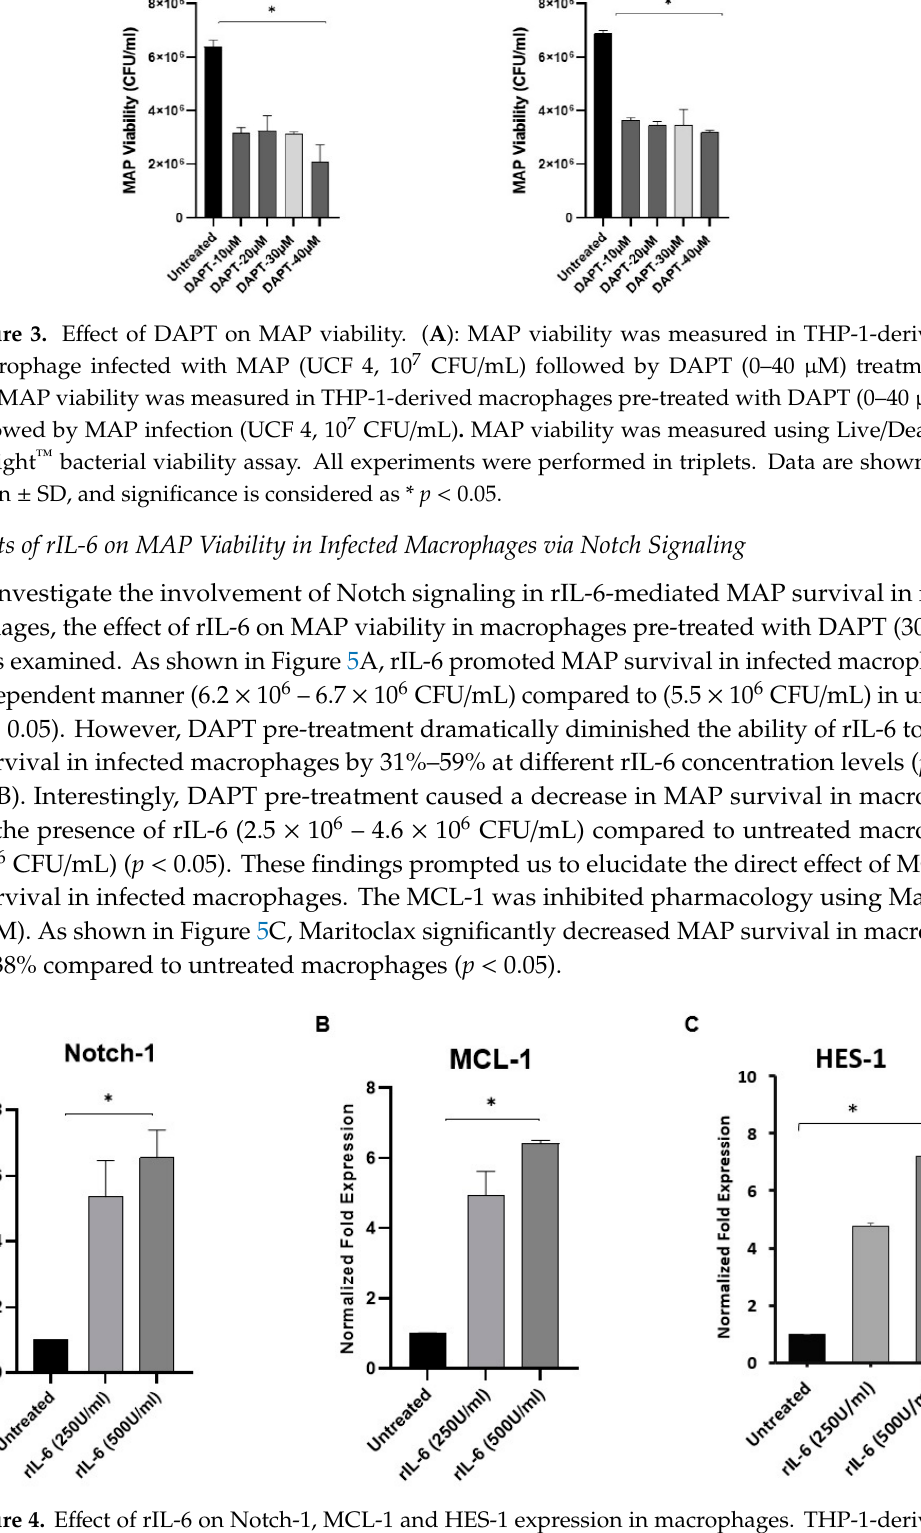
6 of 15 Figure 2. Effect of γ -secretase inhibitor (DAPT) on Notch-1 signaling. ( A–E ): Notch-1, IL-6, MCL-1 and HES-1 expression was measured in macrophages that were pre-treated with DAPT (0–40 μ M) . ( F–J ): Expression levels of Notch-1, IL-6, MCL-1 and HES-1 in THP-1-derived macrophages that were pre-treated with DAPT then infected with MAP (UCF 4, 10 7 CFU/mL) for 24 h. The gene expression levels were measured by RT-PCR. IL-6 protein level was measured using ELISA. All experiments were performed in triplets. Data are shown as mean ± SD, and significance is considered as * p < 0.05. 3.3. Effect of DAPT on MAP Survival in Macrophage via Notch-1 To assess the role of Notch-1 in host defense against infection, MAP viability was measured in DAPT-treated macrophages under two different conditions: Post-infection (Figure 3A) where cells were infected with MAP (10 7 CFU/mL) for 24 h, then treated with DAPT (0–40 μ M) for 24 h, and pre-